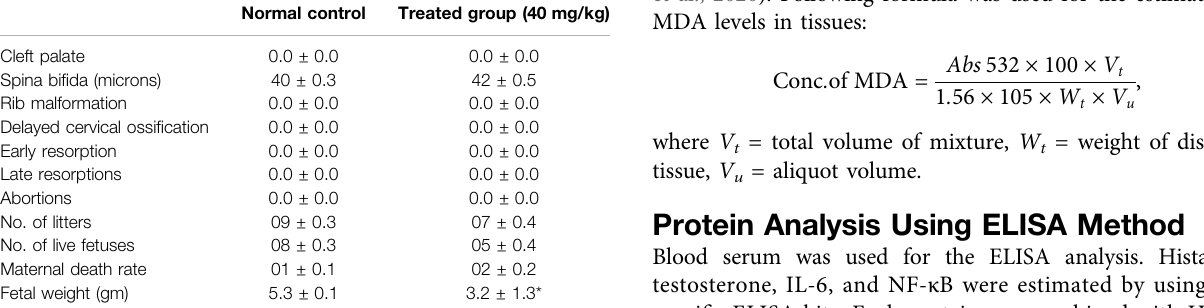
TABLE 3 | Fetal and placental weights and morphological anomalies during the teratogenic study. Anomalies Group Normal control Treated group (40 mg/kg) Cleft